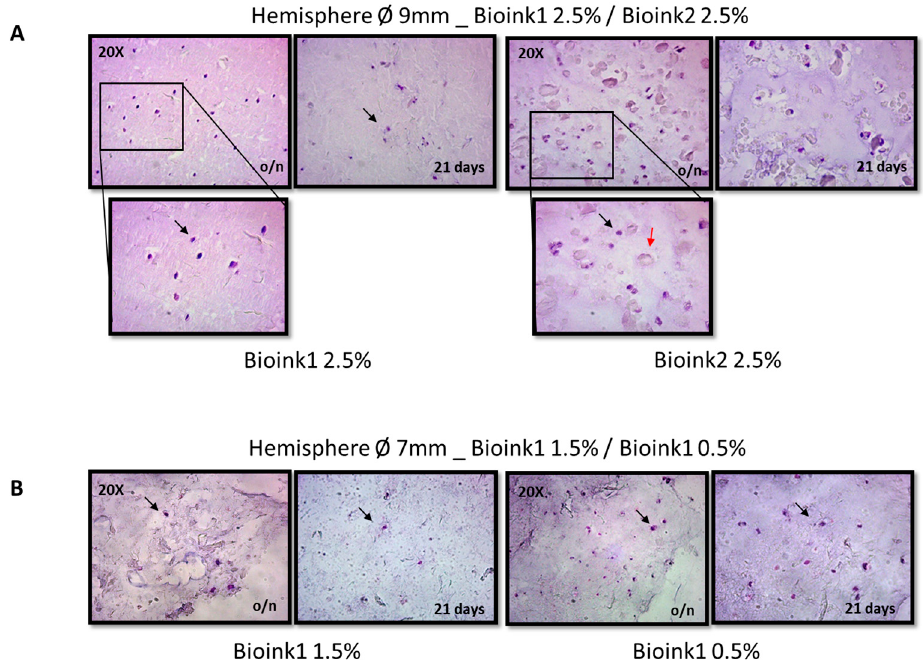
Figure 7. Representative histological staining (H&E) of the bioink1 2.5%/bioink2 2.5% ( A ) and bioink1 1.5%/bioink1 0.5% ( B ) samples. Black arrow indicates hUCMS. Red arrow indicates bioink2’s “oval structures” (20× and 40× magnifications).